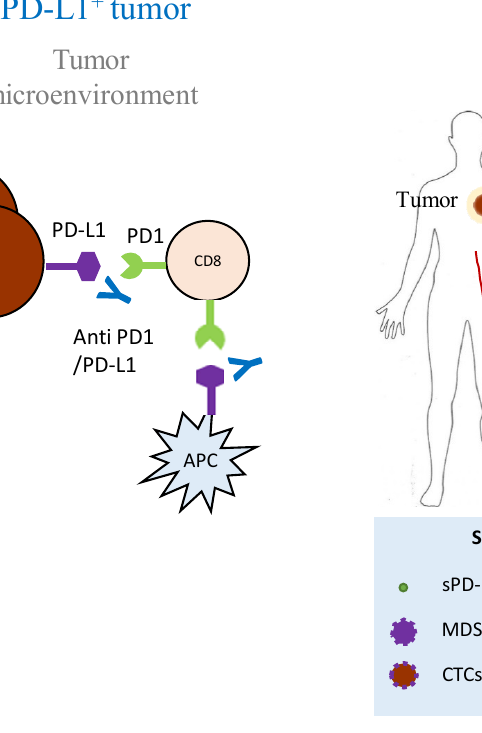
Figure 1. While clinical responses of cancer patients undergoing PD-1 / PD-L1 blockade therapies may be explained by the suppression of the canonical PD-L1 / PD-1 signaling axis, the fact that some patients with negative tumor PD-L1 expression still achieve objective responses highlights the contribution of PD-L1 + systemic immunity—particularly the myeloid compartment—to this kind of treatment. sPD-L1, soluble PD-L1; MDSC, myeloid derived suppressor cells; CTC, circulating tumor cell; DC, dendritic cell; APC, antigen presenting cell.